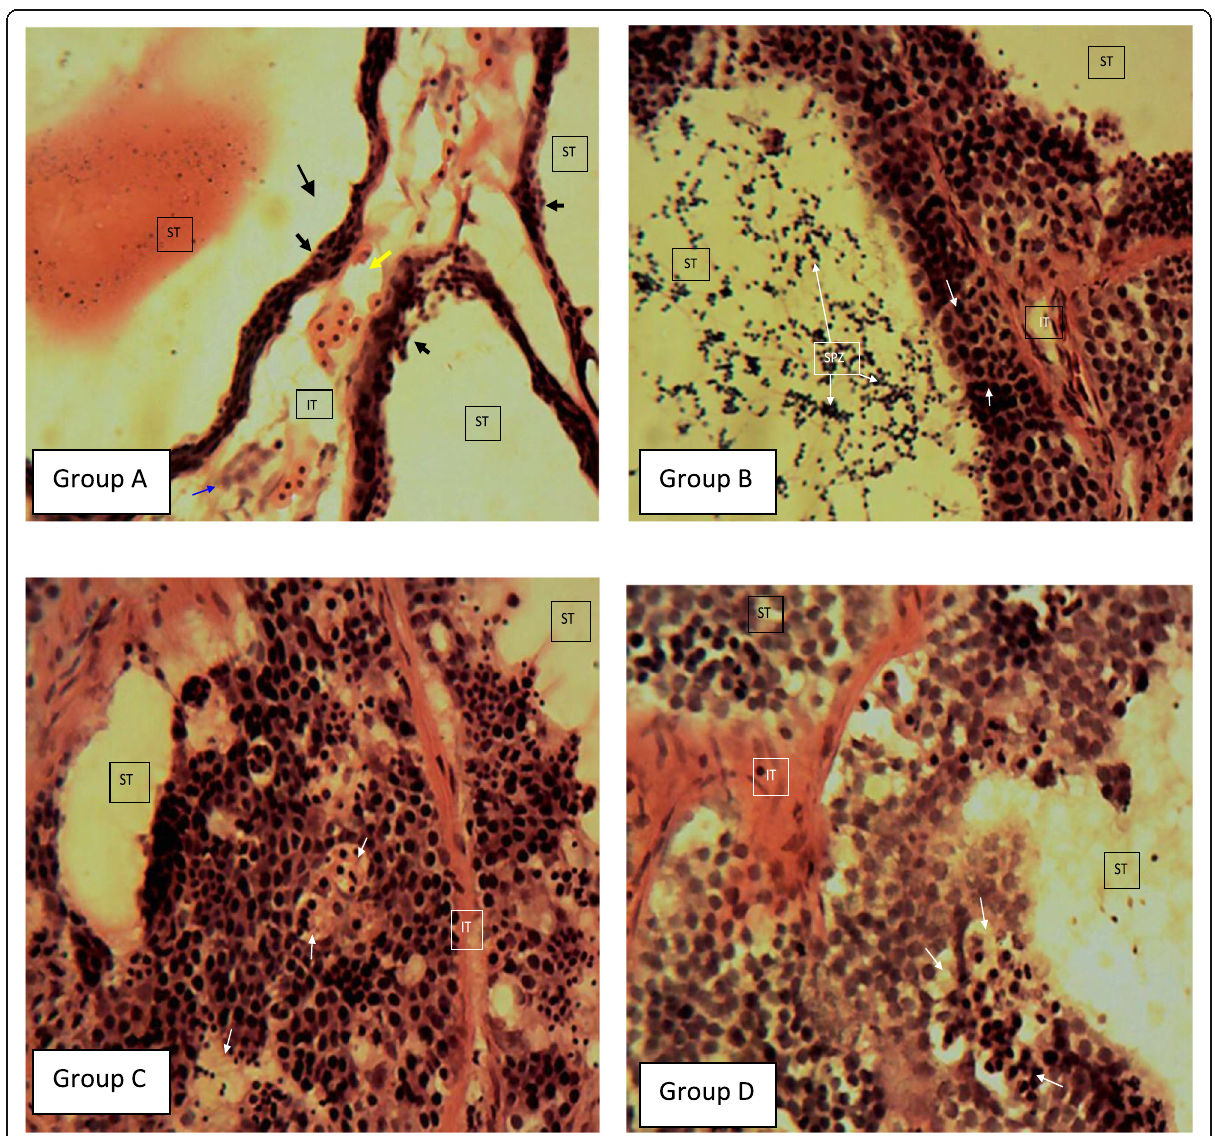
Fig. 2 Histopathology of the testes of C. gariepinus exposed to different concentrations of lambda-cyhalothrin after 1 day. Group A (control), B (2.5 × 10 − 4 μ g/L), C (5.0 × 10 − 4 μ g/L), and D (6.25 × 10 − 4 μ g/L) (testicular interstitium (IT), spermatozoa (SPZ), seminiferous tubules (ST). H&E ×